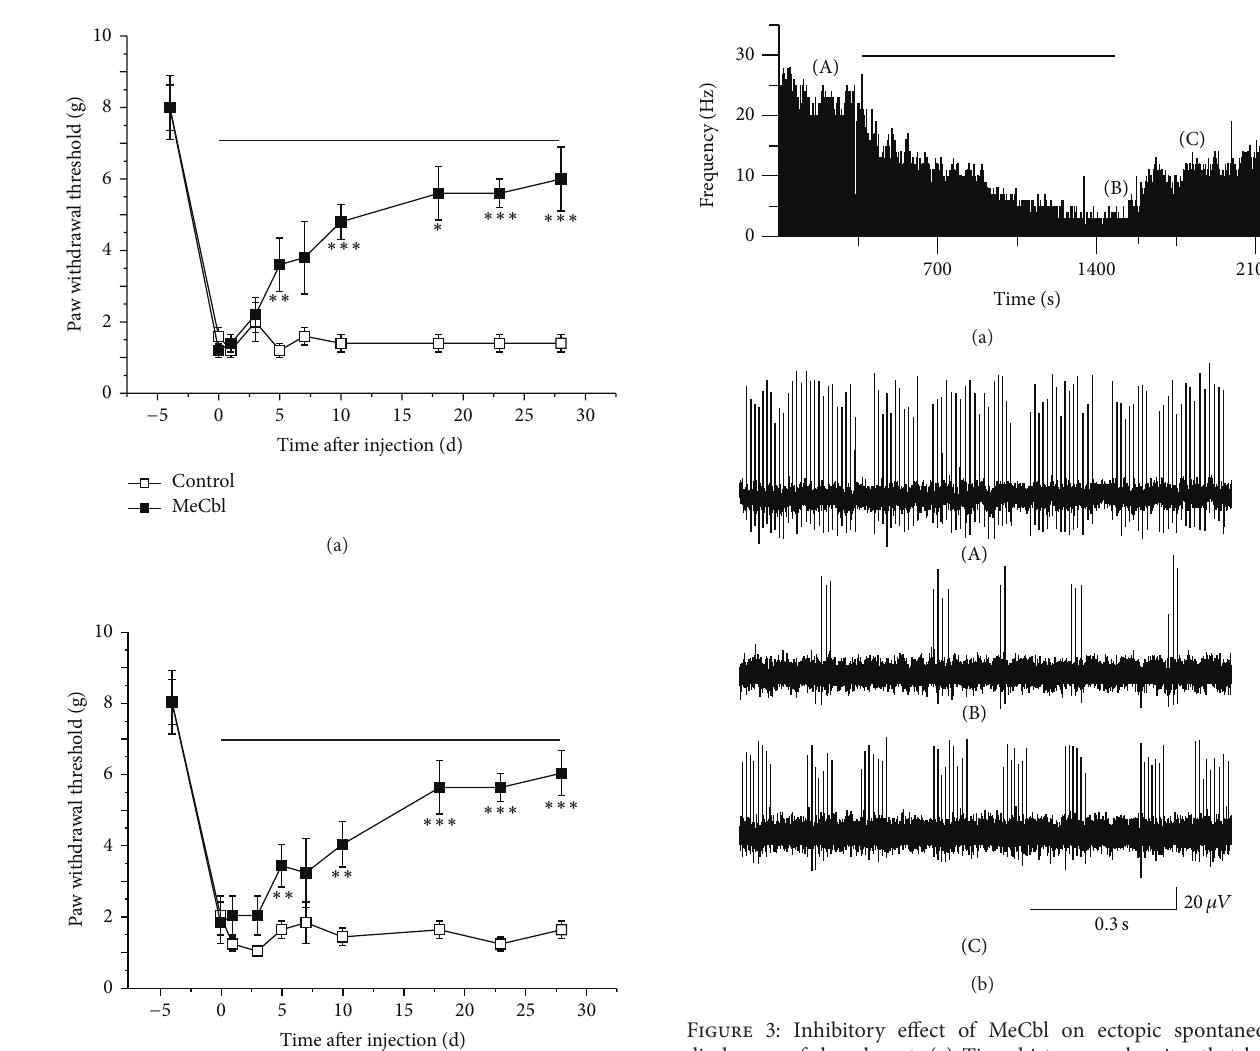
Figure 3: Inhibitory effect of MeCbl on ectopic spontaneous discharges of dorsal root. (a) Time histogram showing that local application of the MeCbl (300 𝜇 mol/L) decreased the basal firing rate of dorsal roots. (b) Three traces in right panel show firing patterns before (A), during (B), and wash out (C) the application of